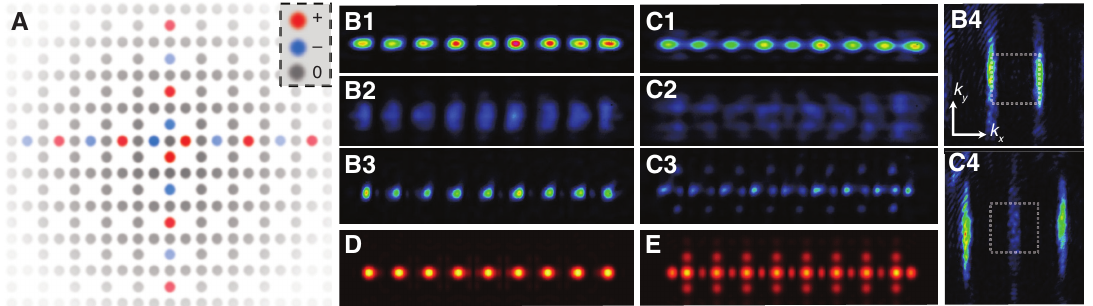
Figure 6: Demonstration of unconventional line states in a photonic Lieb lattice [81]. (A) Schematic illustration of two flat-band NLSs in an infinite Lieb lattice. (B–E) Experimental results of line states in a finite Lieb lattice with bearded edge. (B1) Out-of-phase input line beam. (B2) Out-of-phase output without the lattice. (B3) Out-of-phase output through the lattice. (B4) Measured k -space spectrum of (B3), with a dashed square marking the first BZ. (C1–C4) The same as in (B1–B4) but the line beam is in-phase. (D, E) Numerical simulation results showing the out-of-phase line beam remains intact but the in-phase line deteriorates after propagating a long distance through the